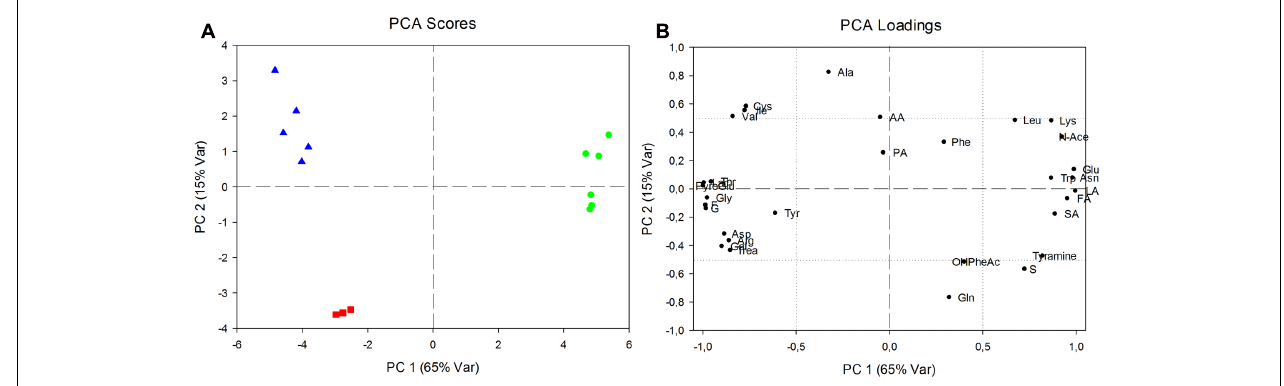
FIGURE 4 | Analysis of production and consumption of metabolites, expressed by net balances. (A) Principal components analysis (PCA) score plot relative to L. delbrueckii 23 (green circles), L. delbrueckii bulgaricus (red squares) and L. delbrueckii lactis (blue triangles). Eighty percent of total variability represented in two components (PC1: 65%; PC2: 15%). (B) PCA loadings plot indicating statistically significant differences of excreted or consumed metabolites between the two L. delbrueckii 23 and L. delbrueckii lactis with respect to L. delbrueckii bulgaricus along PC1, or between both L. delbrueckii lactis subspecies and L. delbrueckii bulgaricus along